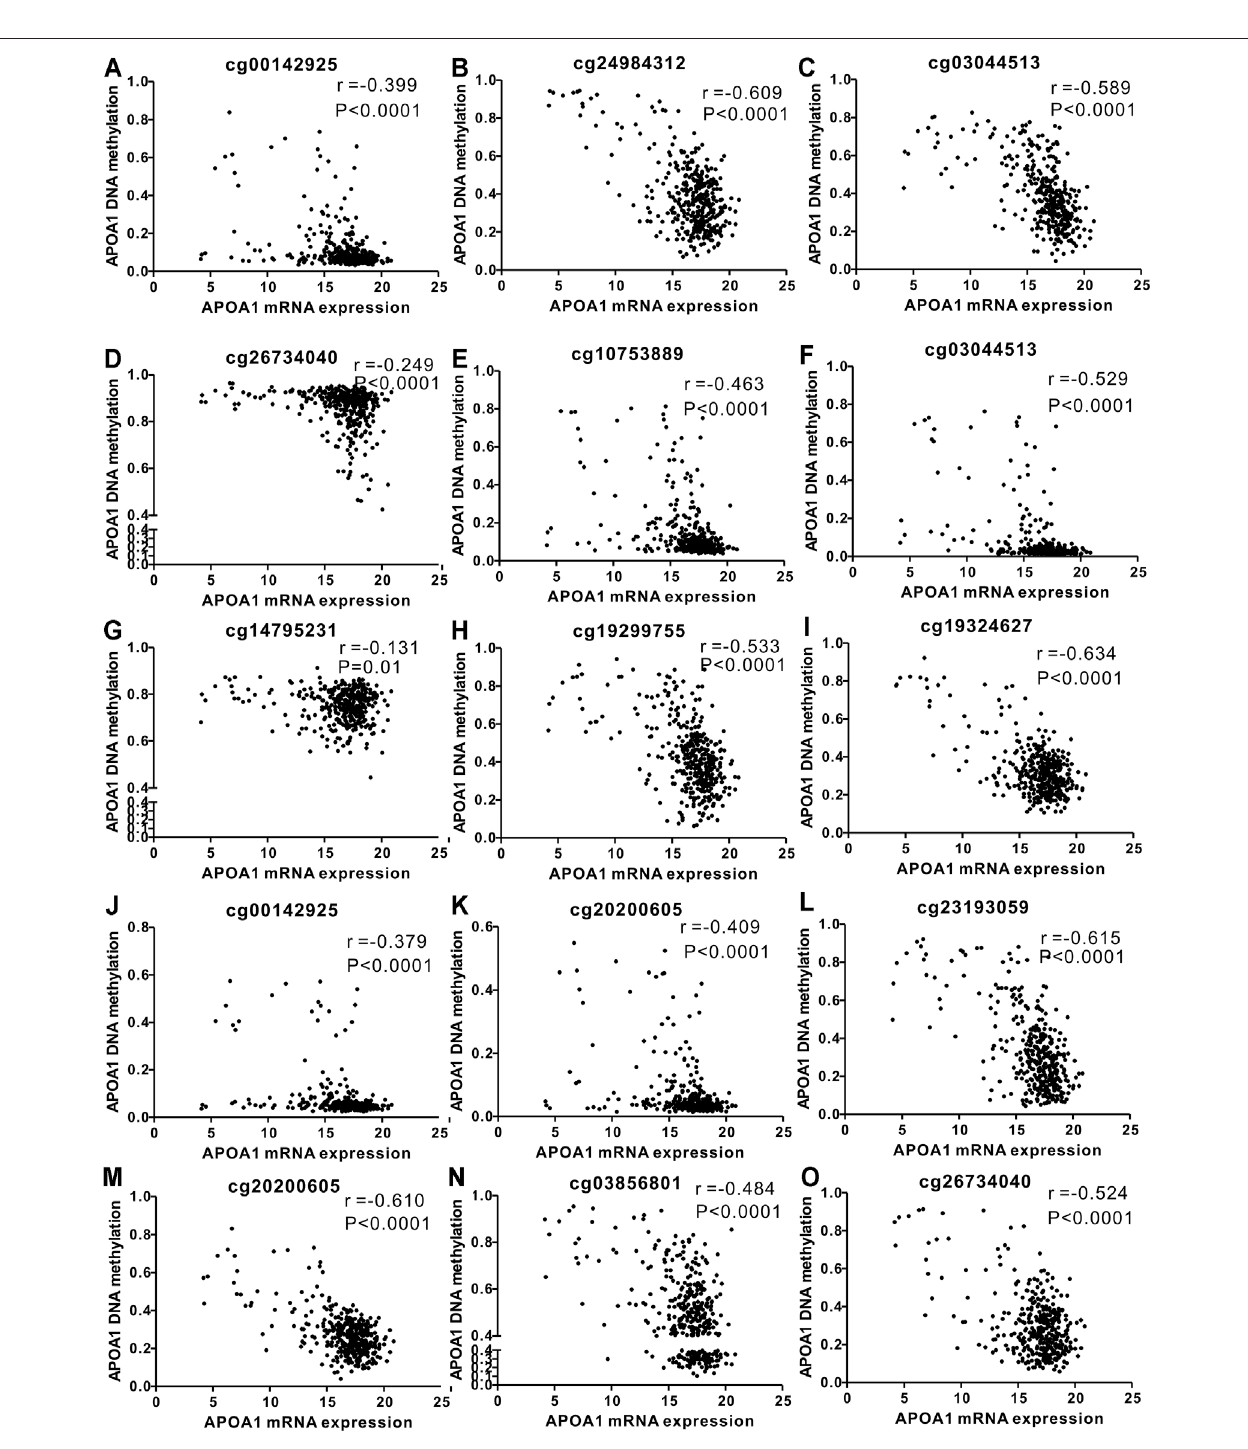
FIGURE 5 | Correlation analysis of the relationship between APOA-1 mRNA expression and methylation of APOA-1 DNA CpG sites in TCGA dataset. (A) cg00142925; (B) cg24984312; (C) cg03044513; (D) cg26734040; (E) cg10753889; (F) cg03044513; (G) cg14795231; (H) cg19299755; (I) cg19324627; (J) cg00142925; (K) cg20200605; (L) cg23193059; (M) cg20200605; (N) cg03856801; and (O)